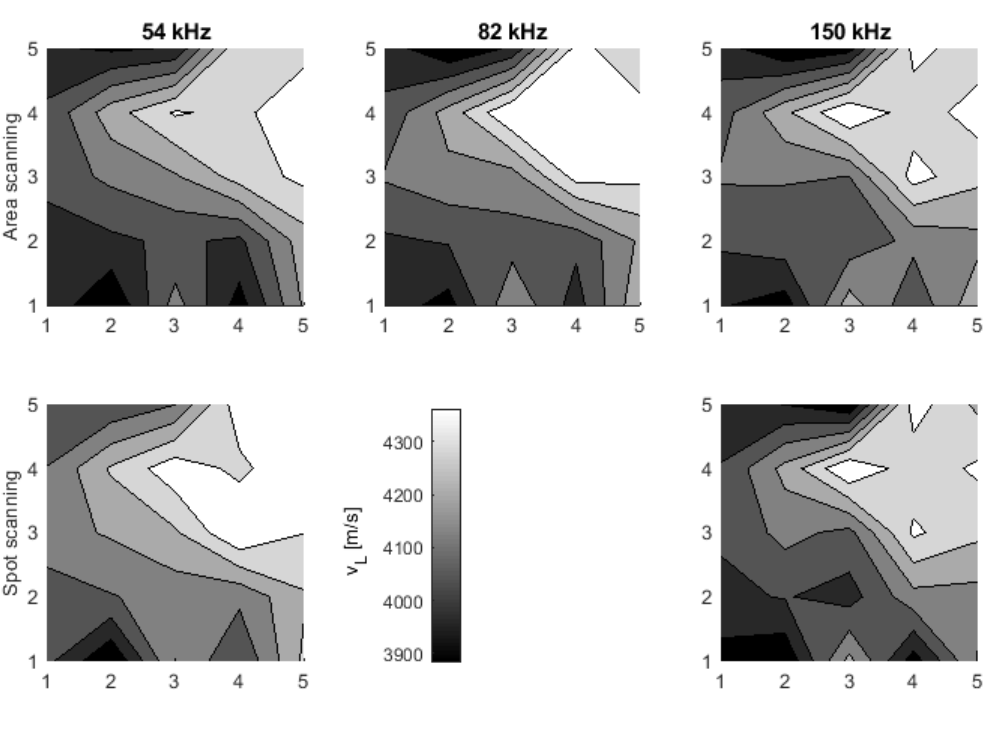
Figure 2. A contour diagram of the test results of area and spot scanning.